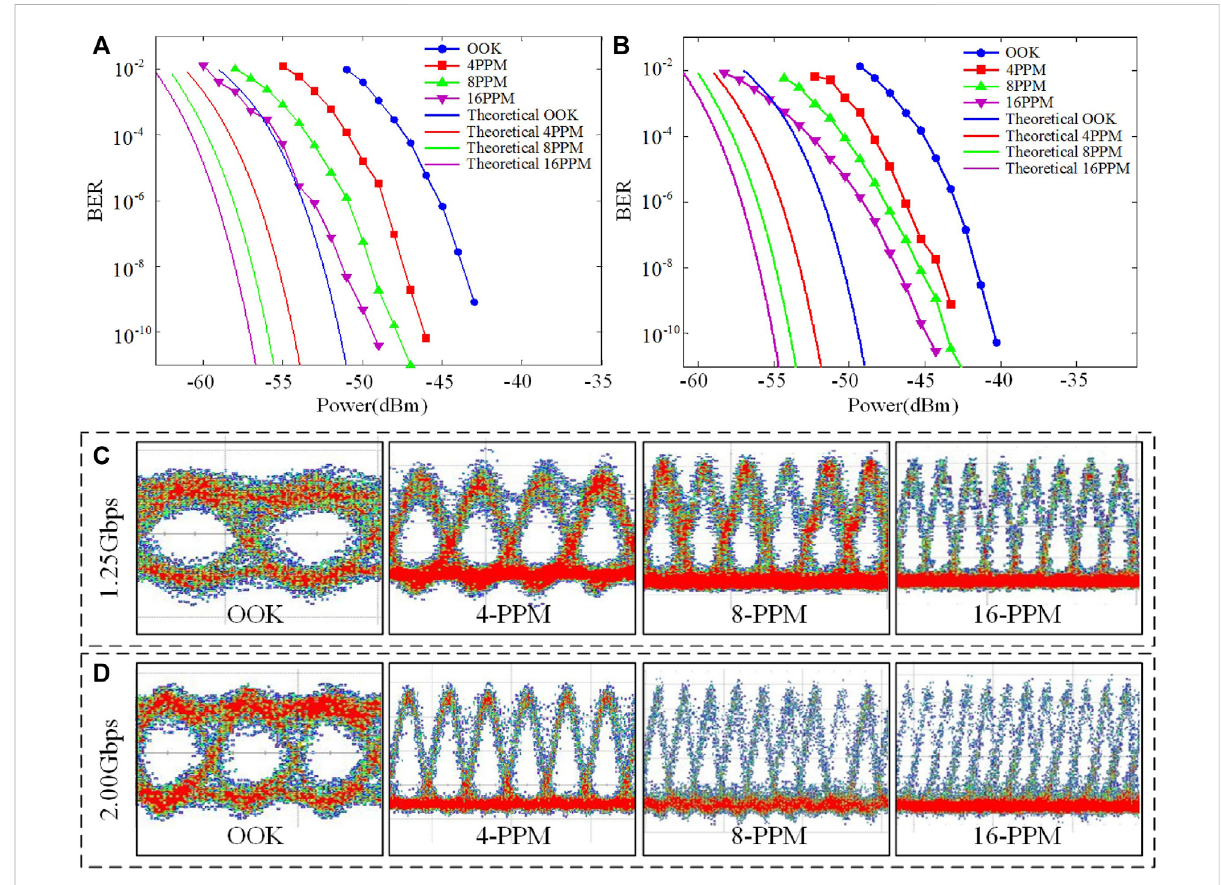
FIGURE 5 BER analysis ofreceived optical power for (A) 1.25 Gbps and (B) 2.00 Gbps. (C) Eye diagrams of 1.25 Gbps and (D) 2 Gbps signals atthe receiver terminal.